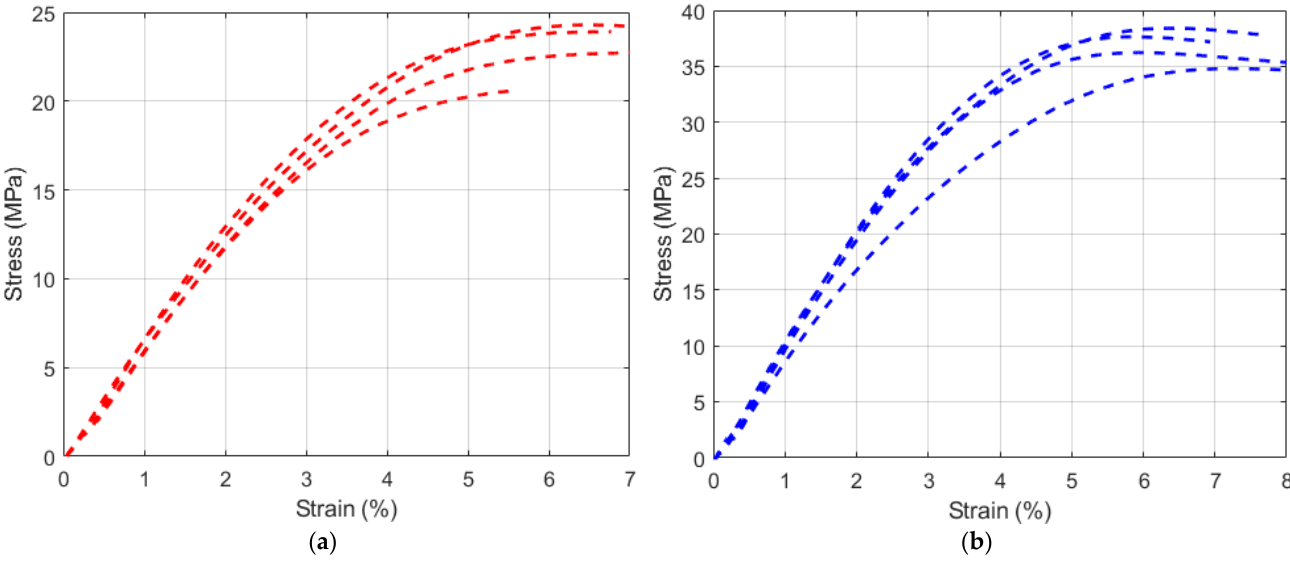
Figure 6. Tensile strength results of UV resin samples ( a ) Conductive UV resin (red) ( b ) Non-conductive UV resin (blue).